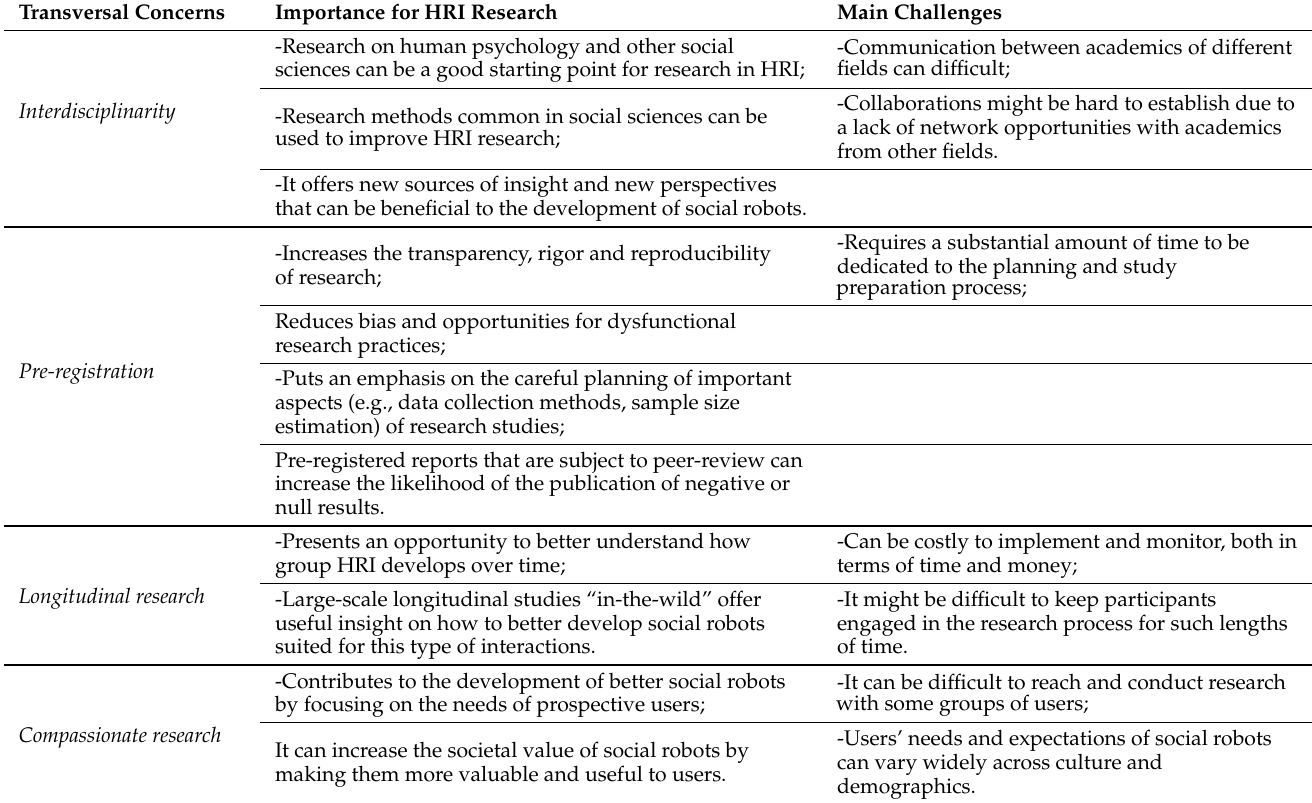
Table 2. Summary of the main transversal concerns discussed in this paper, and their relation to the field of HRI research in terms of the advantages and challenges they